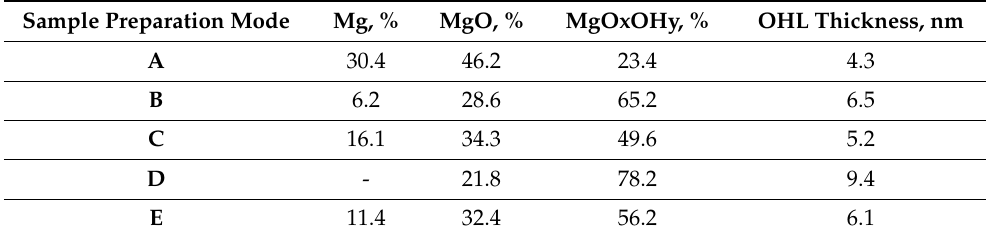
Table 4. Integral intensity of peaks in Mg2p XPS spectra and total thickness of the OHL upon sample preparation in different modes.